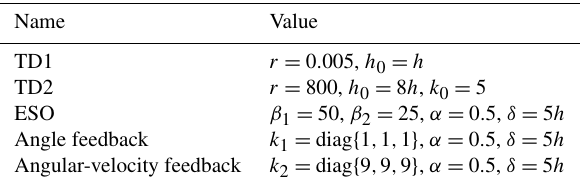
Table 4. Parameters of the ADRC control.